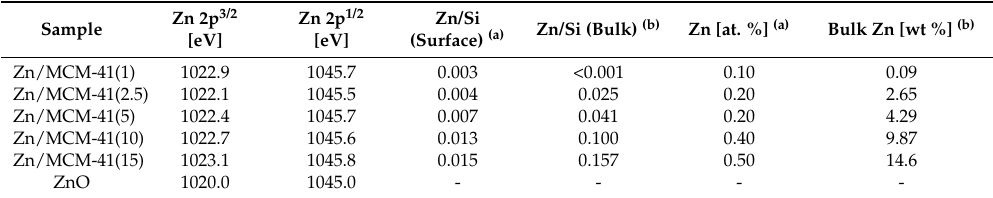
Table 2. Binding energies values (eV) for Zn 2p spectra and surface Zn/Si compositions of Zn/MCM-41(x) samples and reference ZnO. Sample